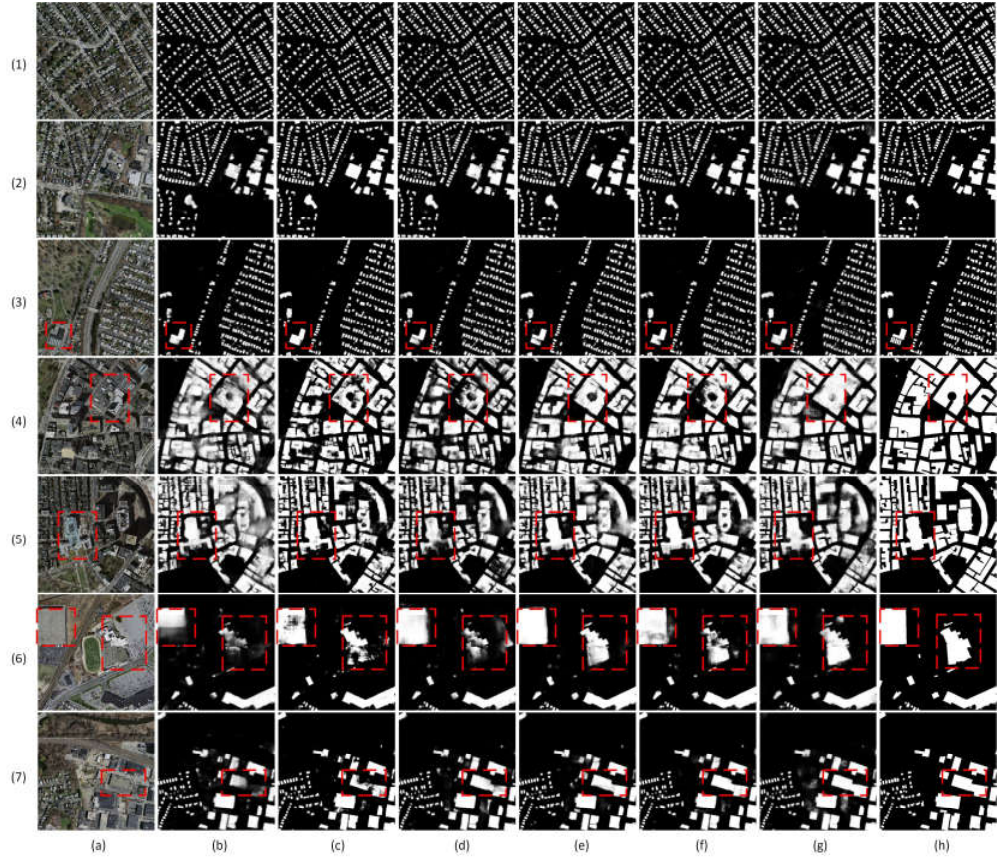
Figure 12. Comparison of building extraction results on Massachusetts building datasets: ( a ) Input Image. ( b ) Result from U-Net. ( c ) Result from Res-U-Net. ( d ) Result from MSMT. ( e ) Result from TernausNetV2. ( f ) Result from JointNet+BCE. ( g ) Result from JointNet@448 × 448+BCE. ( h ) Ground truth.